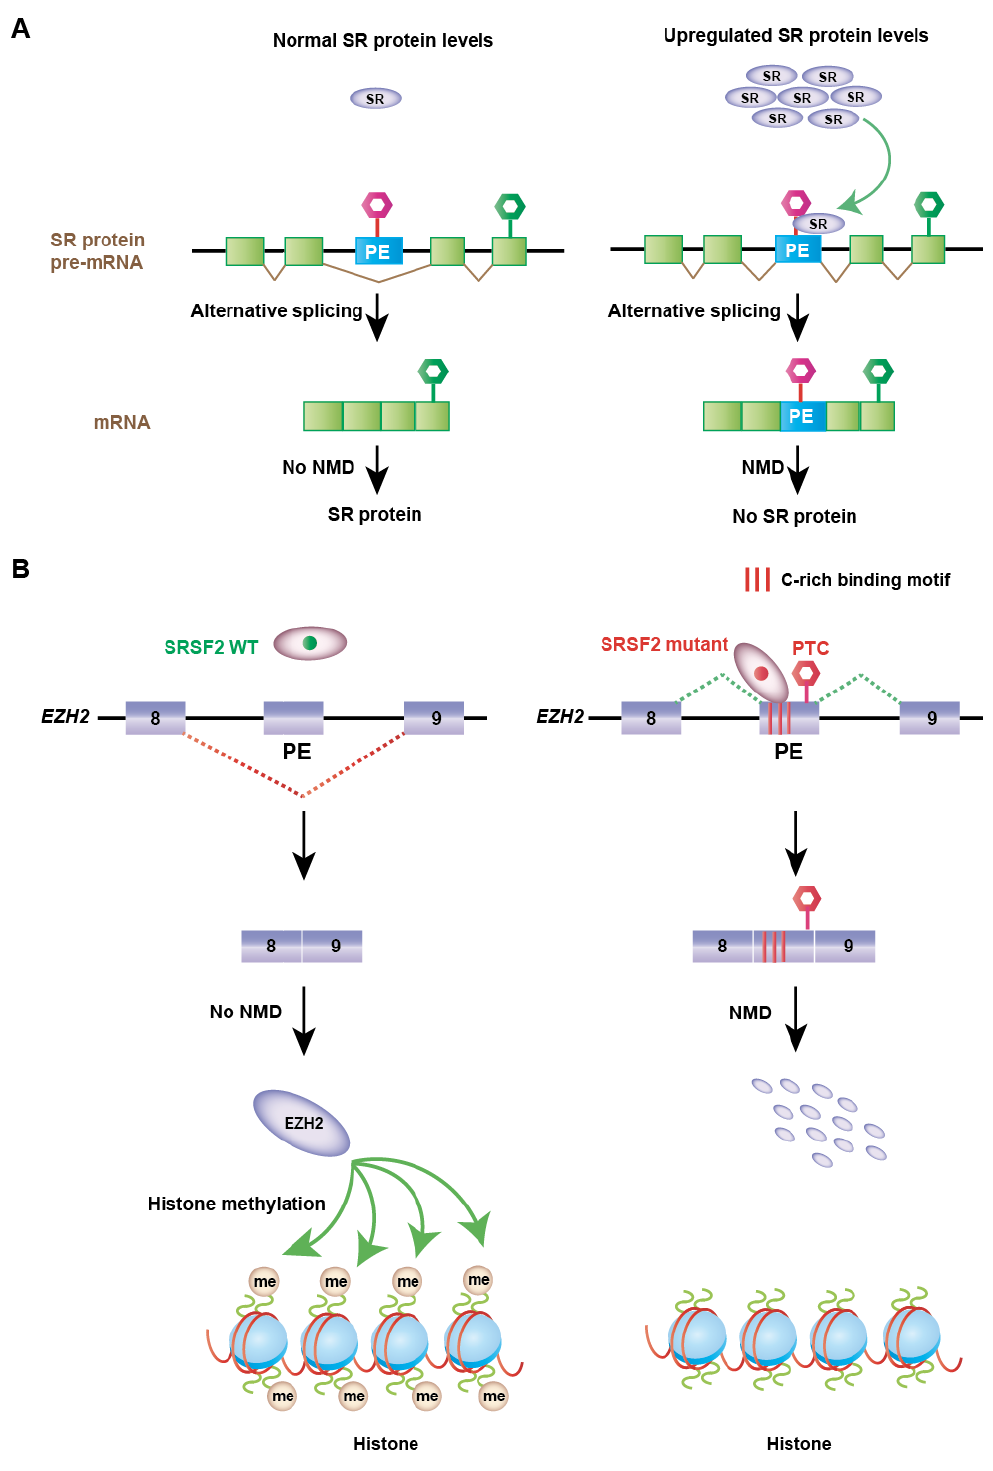
Figure 5. Regulation of AS-NMD in cancer. ( A ) When SR proteins are overexpressed in normal cells, they autoregulate their expression via AS-NMD for homeostasis. SR protein genes harbor ultraconserved regions containing non-coding exons, also called poison exons (PEs) or 3′UTR poison sequences (PSs). When poison exons are included, they introduce a premature termination codon (PTC) and target the mRNAs for degradation. In contrast, splicing of the 3′UTR poison sequences introduces a new exon–exon junction, which marks the original stop codon as a PTC and elicits NMD. SR protein autoregulation via AS-NMD is inhibited in certain tumors. ( B ) SRSF2 is recur- rently mutated in hematologic malignancy. One aberrant AS-NMD event promoted by the mutant